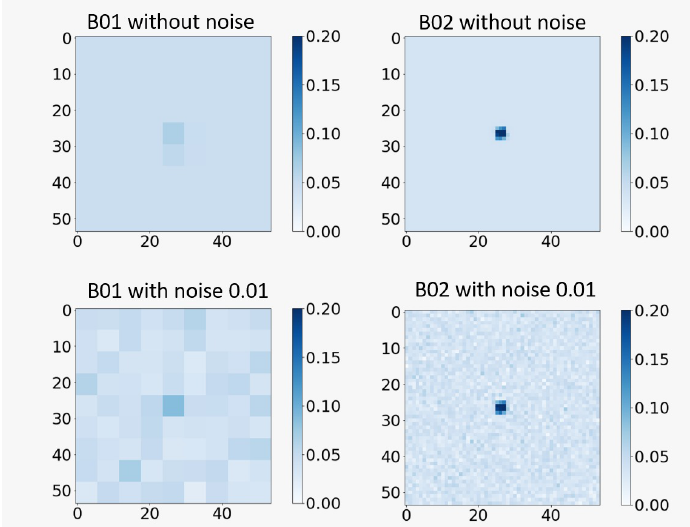
Figure 5. Simulated images of a 30m × 30m plastic patch made out of wet bottles frame for B01 and B02 only; with and without noise.